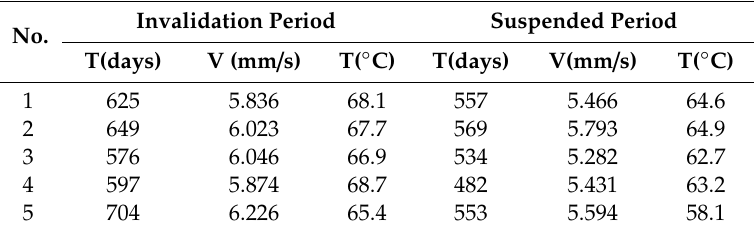
Table 4. Invalidation period and the suspended period for an OWT gearbox.